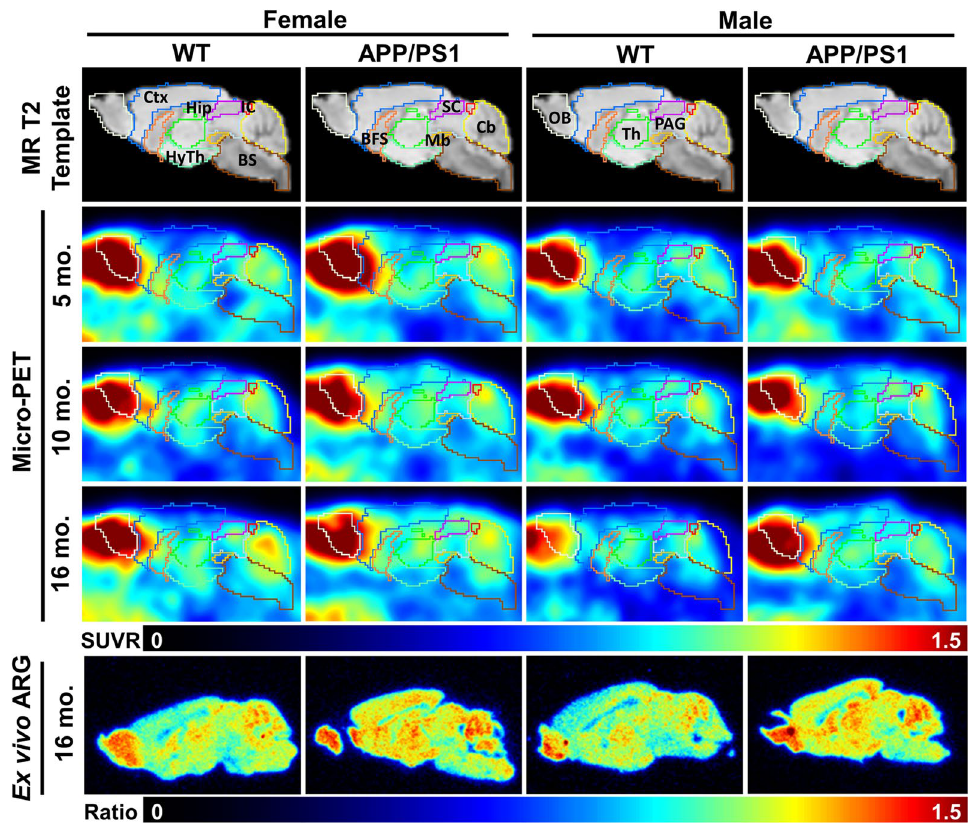
Fig. 3 In vivo [ 18 F]ROStrace retention is increased in the APP/PS1 model of AD and demonstrates a female sex bias. Sagittal view of [ 18 F]ROStrace SUVR 40‑60 PET images collected from both sexes of WT and APP/PS1 mice at 5 mo., 10 mo., and 16 mo. Brain subregions derived from Mirrione mouse brain atlas. Ctx: cortex, OB; olfactory bulb, BFS: basal forebrain septum, Hip: hippocampus, HyTh: hypothalamus, SC: superior colliculi,